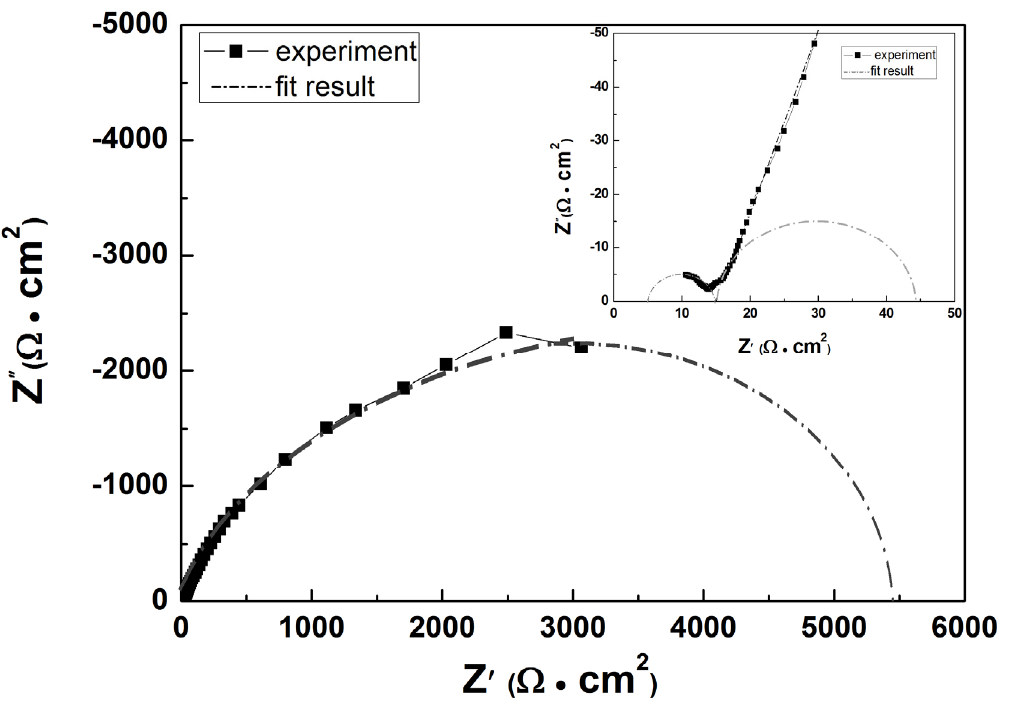
Figure 4. The Nyquist plot obtained for a mild steel sample at 150 mA·m − 2 over 72 h immersion in artificial seawater and plotted together with modelling curve based on equivalent circuit of Figure